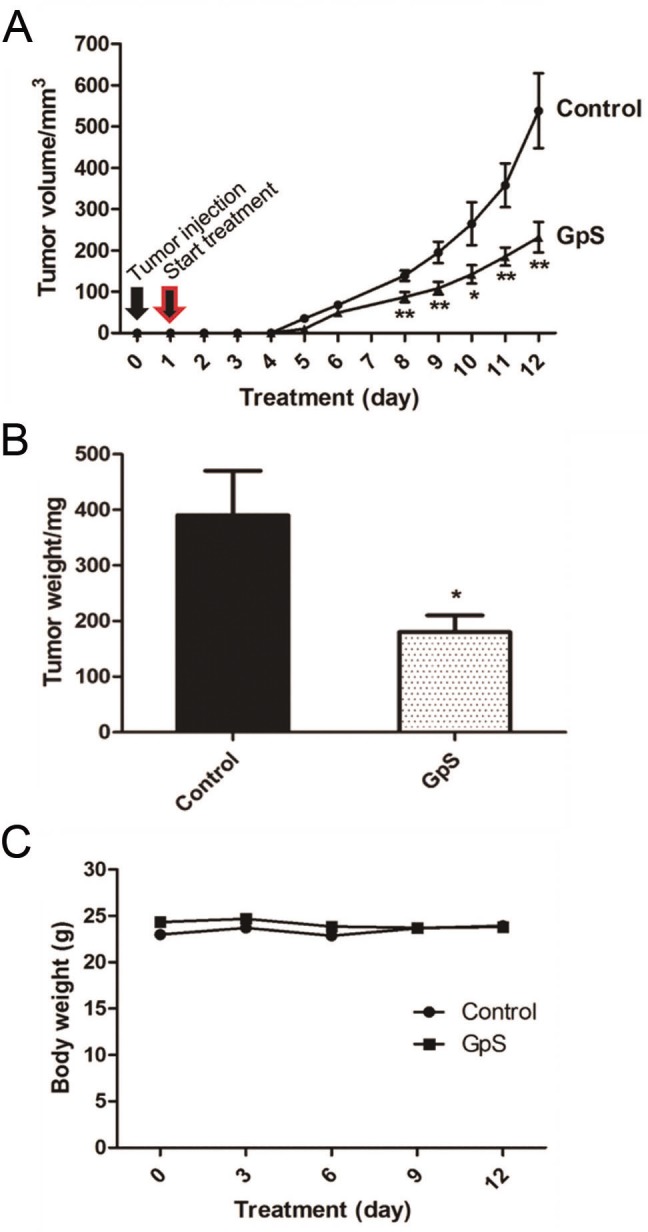
Effect of GpS on tumor growth in nude mice.(A) Tumor volume, (B) Tumor weight and (C) Body weight. Xenografting was performed by injecting 106 R6/GFP-ras transformed cells into the flank of each 7- to 8-wk-old mouse. A single dose of GpS at 750 mg/kg or solvent control was administered daily by gavage and the feeding was initiated the second day after implanting the GFP-ras cells. All data are presented as the mean ± SEM (* P < 0.05, ** P < 0.01 versus control) (n = 7/group).